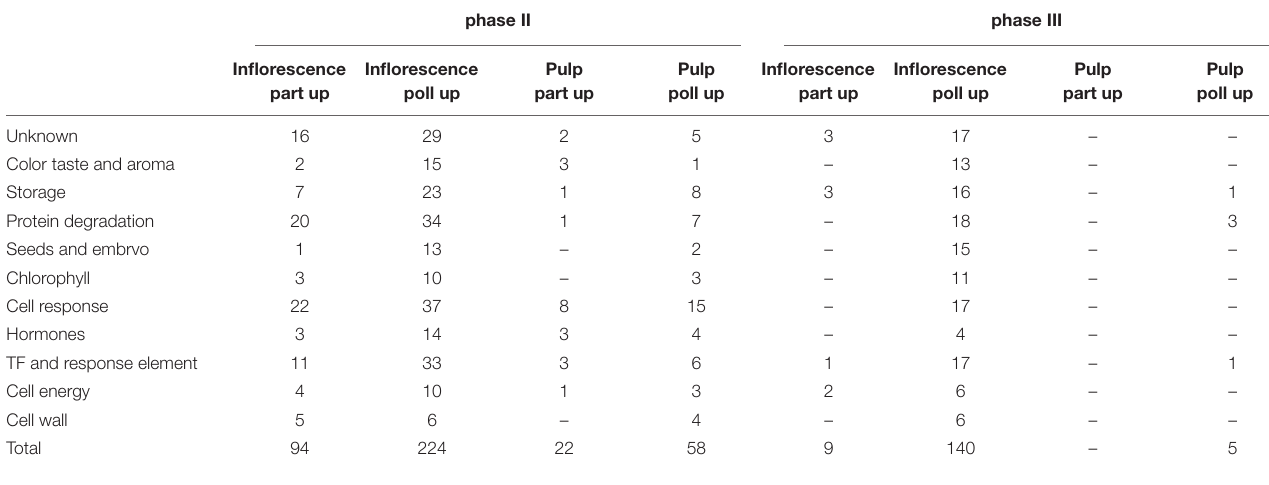
TABLE 2 | Up-represented molecular function groups for each development phase in parthenocarpic (part) and pollinated (poll) inflorescence and pulp